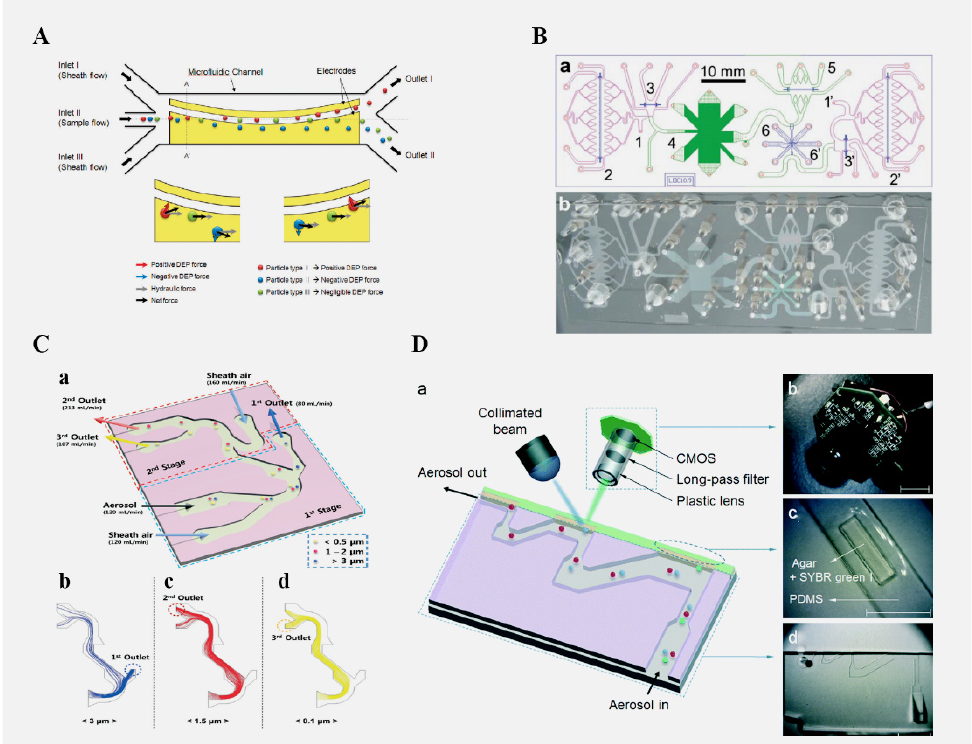
Figure 2. ( A ) Schematic diagram of the DEP separator. Reproduced with permission from ref. [89]. Copyright 2009 American Chemical Society. ( B ) Schematic drawing of laboratory-on-chip. (a) LOC- DLA, (b) picture of its assembly with manifold. Reproduced with permission from ref. [91]. ( C ) Schematic diagram of the inertial separation principle and the Dean vortices in the curved micro- channel. (a) Design and operating conditions of the separator. (b), (c), (d) Trajectories of airborne particles 0.1, 1.5, 3 μ m in diameter in the separator, respectively. Reproduced with permission from ref. [92]. Copyright 2015 Royal Society of Chemistry . ( D ) Structure of the centrifugation-based mi- crofluidic chips for the collection of bioaerosols. (a) Schematic diagram of the present airborne mi- crobe detection chip, (b) mini-fluorescent microscope, (c) disposable cartridge-type PDMS impac- tion plate with an impaction zone, and (d) microchannel with three impaction stages (all scale bars indicate 1 cm). Reproduced with permission from ref. [90]. Copyright 2014 Royal Society of Chem- istry . Copyright 2011 Royal Society of Chemistry .